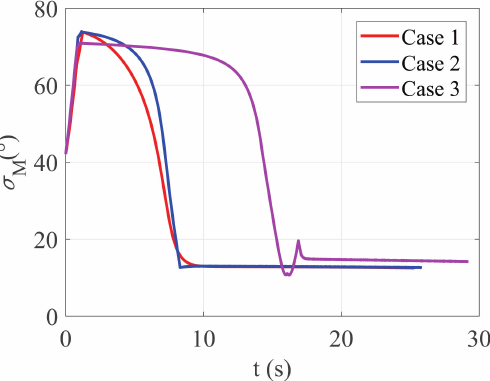
Figure 7. Variations of overall leading angles against constant maneuvering